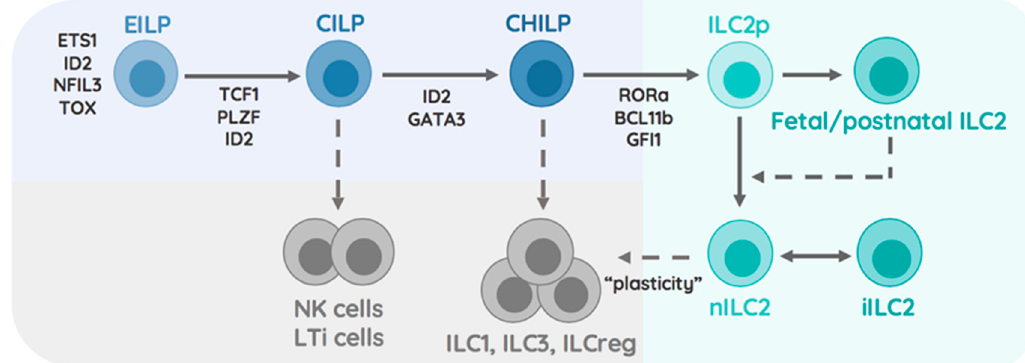
Figure 1. Development of ILC2. This scheme demonstrates the subdivision of the ILC2 lineage into oligo-potent precursors (Blue), non-ILC2 lineages (Grey), and the ILC2 lineage (Green). The Early Innate Lymphocyte Precursor (EILP) expresses ETS1, ID2, NFIL3, TOX, and differentiates into the Common Innate Lymphocyte Precursor through the expression of TCF1 and PLZF. These precursors give rise to NK cells, LTi cells (dashed arrow) and the Common Helper Innate Lymphocyte Precursor (CHILP). ID2 and GATA3-dependent CHILP lose the potential to generate NK cells and LTi cells while retaining the ability to generate ILC1, ILC3, and ILCreg (dashed arrow). Upregulation of RORa, BCL11b, and GFI1 within CHILP restrict the development of ILC2 progenitors that differentiate into fetal/postnatal ILC2 and adult/natural ILC2. Fetal/postnatal ILC2 may differentiate into natural ILC2 (dashed arrow). Natural ILC2s differentiate into inflammatory ILC2 under circumstance of tissue perturbation and respond to environmentally-induced signal by destabilizing their ILC2 phenotype and adapting ILC1/ILC3 effector functions possibly termed ‘plasticity’(dashed arrow).